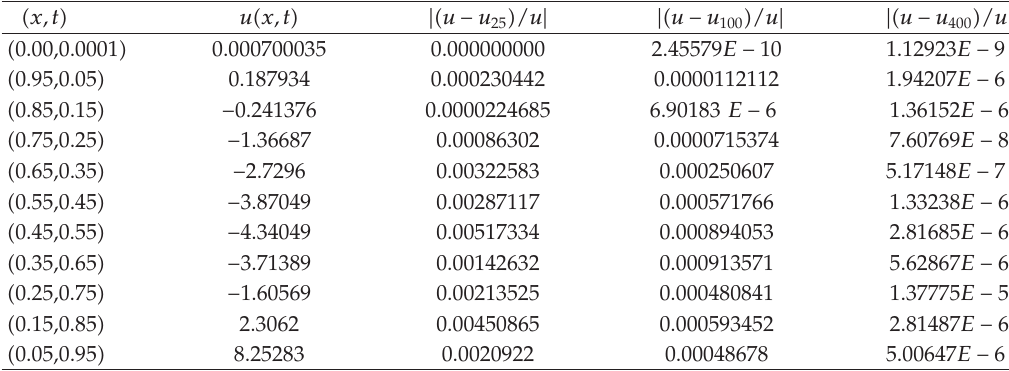
Table 1: Numerical